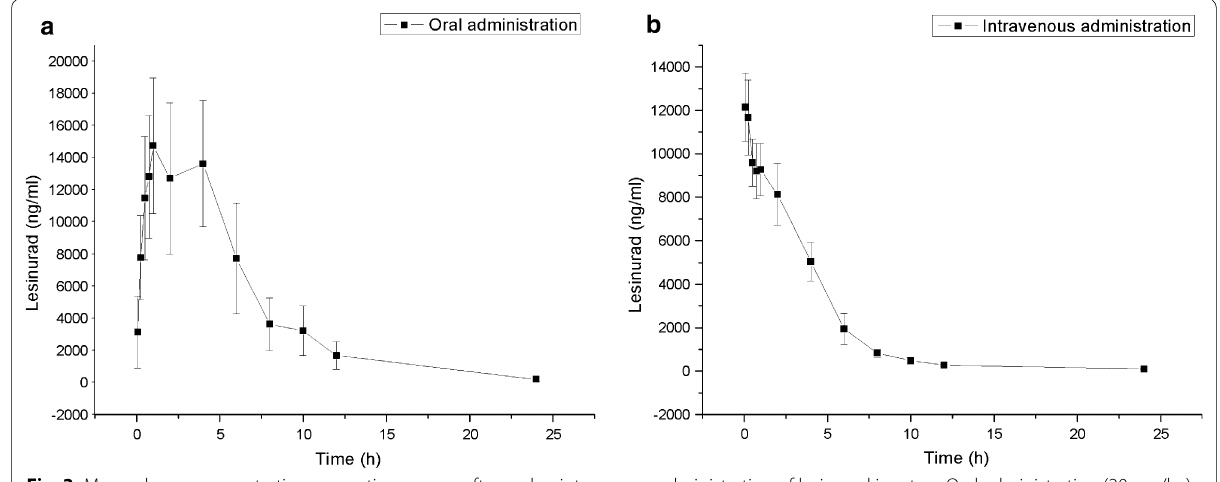
Fig. 3 Mean plasma concentration versus time curves after oral or intravenous administration of lesinurad in rats. a Oral administration (20 mg/kg); b intravenous administration (5